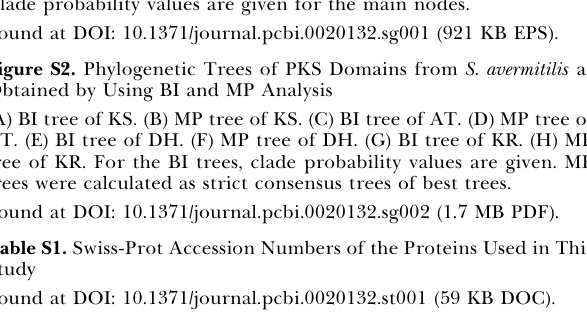
Figure S1. Phylogeny of the KS Domains of Selected PKS Clusters from Streptomyces S trains as Obtained by BI Clade probability values are given for the main nodes. Figure S2. Phylogenetic Trees of PKS Domains from S. avermitilis as Obtained by Using BI and MP Analysis (A) BI tree of KS. (B) MP tree of KS. (C) BI tree of AT. (D) MP tree of AT. (E) BI tree of DH. (F) MP tree of DH. (G) BI tree of KR. (H) MP tree of KR. For the BI trees, clade probability values are given. MP trees were calculated as strict consensus trees of best trees. Found at DOI: 10.1371/journal.pcbi.0020132.sg002 (1.7 MB PDF). Table S1. Swiss-Prot Accession Numbers of the Proteins Used in This Study Found at DOI: 10.1371/journal.pcbi.0020132.st001 (59 KB